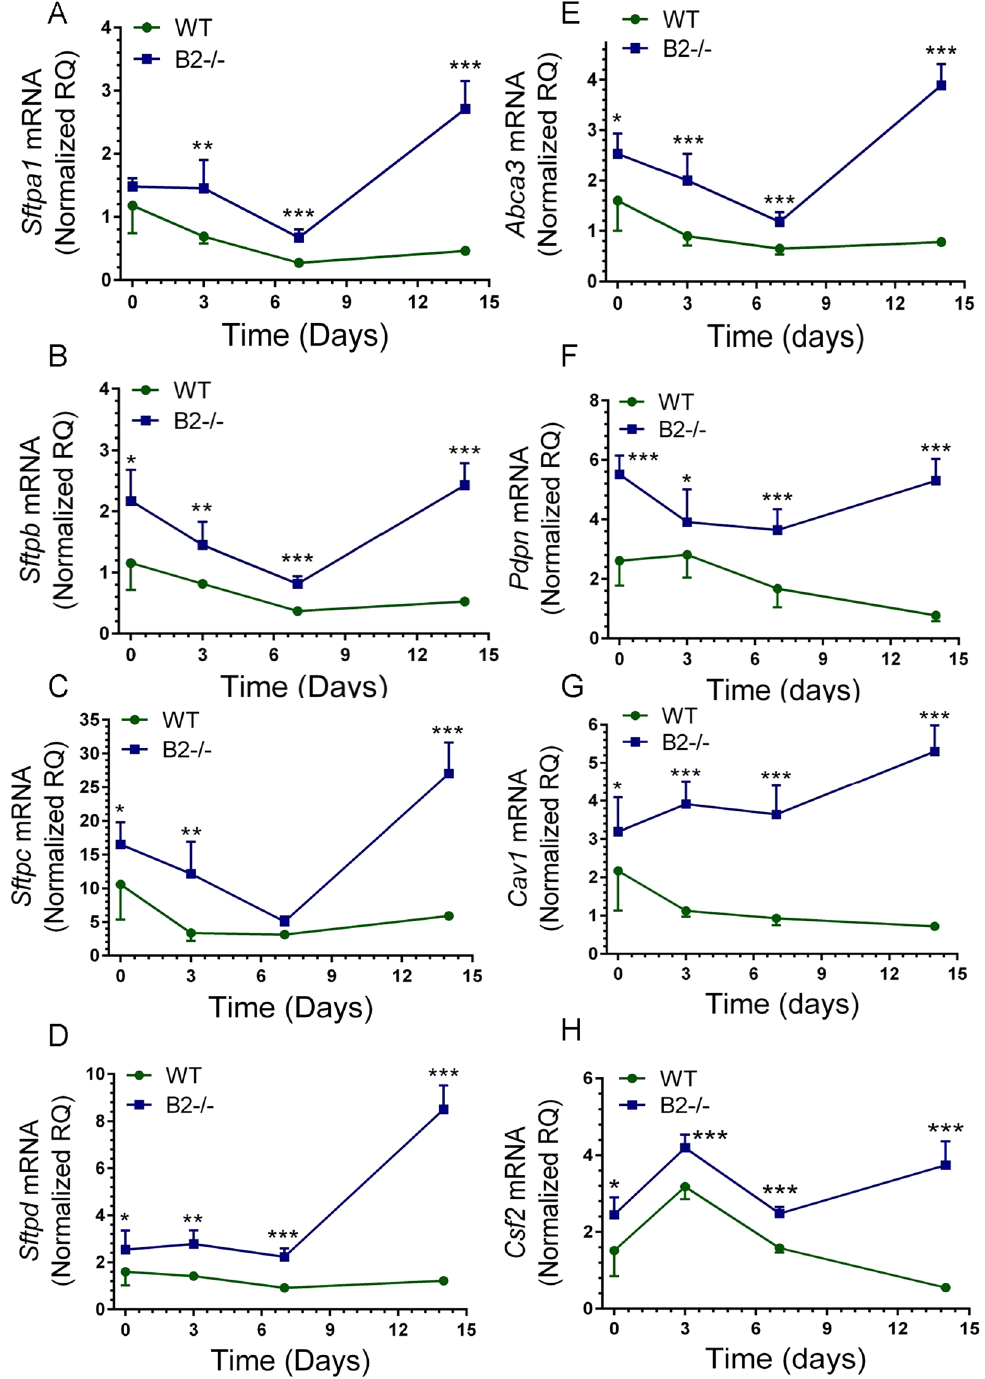
Figure 2. Disruption of endophilin B2 prevents suppression of alveolar epithelial and endothelial genes by IAV infection. The mRNA levels of ( A ) Sftpa1 , ( B ) Sftpb , ( C ) Sftpc , ( D ) Sftpd , ( E ) Abca3 , ( F ) Pdpn , ( G ) Cav1 , and ( H ) Csf2 in WT and B2 − / − mice were quantitated by qRT-PCR in total lung. Data were normalized to 18S rRNA and expressed as relative quantity (RQ) compared to WT uninfected control treated with DPBS vehicle. *** p < 0.00001: * p < 0.006 (for WT n = 4, 9, 8, and 6 and B2 − / − n = 3, 7, 8, and 6 at t = 0, 3, 7, and 14 days; the vehicle treated mice are plotted as t =